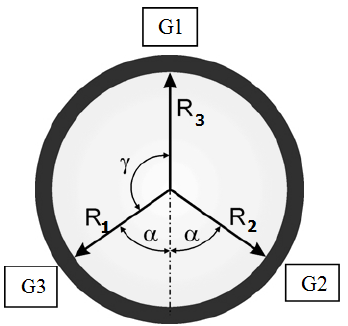
Figure 3. Positions of three separate air gauges, G1, G2, and G3, in the gauging head. Another novelty of the presented method is the concept of the floating gauging